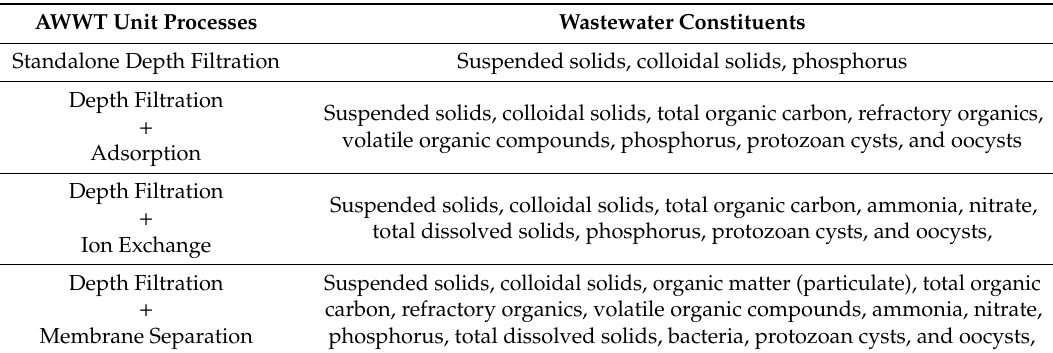
Table 1. The wastewater constituents that could be removed by the di ff erent advanced wastewater treatment (AWWT) unit